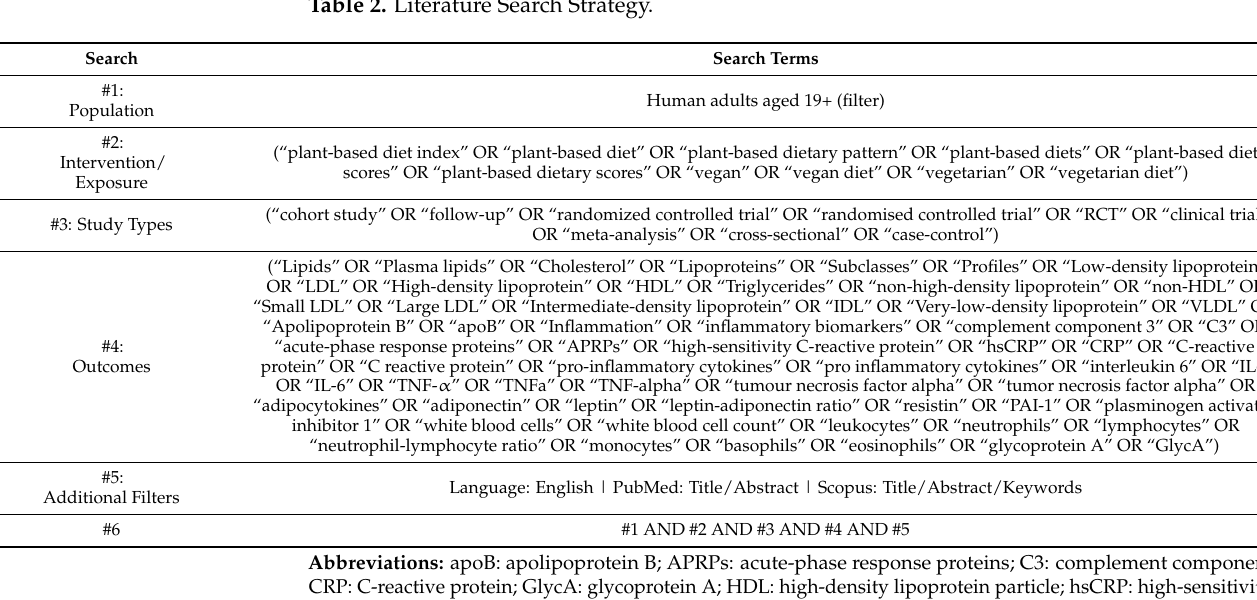
Table 2. Literature Search